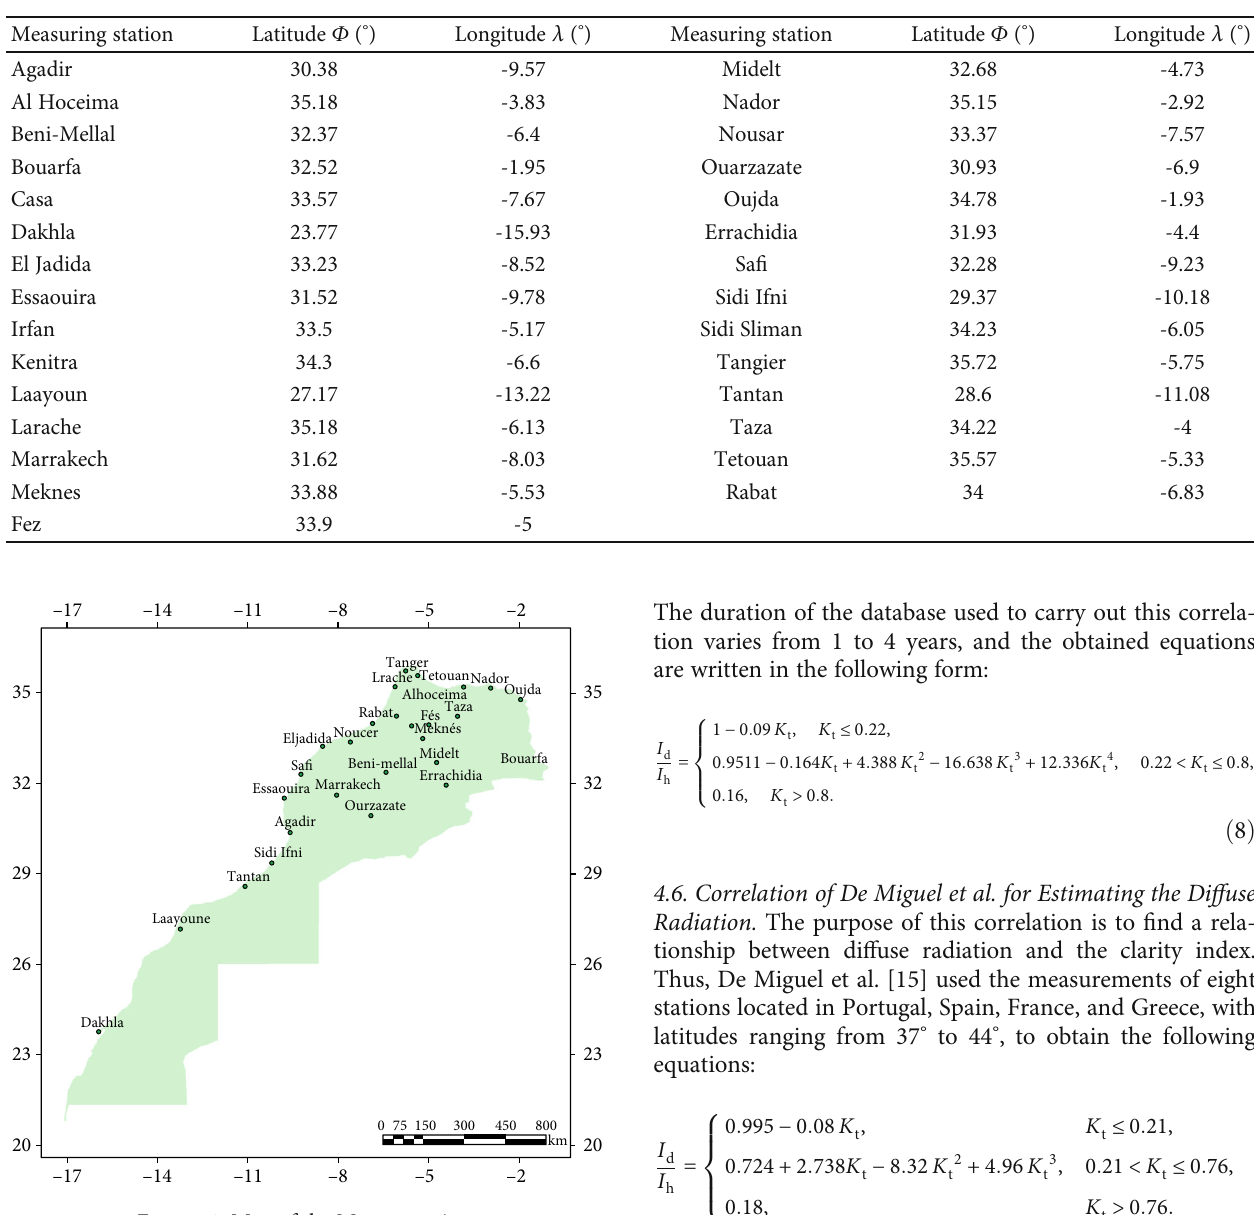
Table 3: The locations of the Moroccan sites [42].